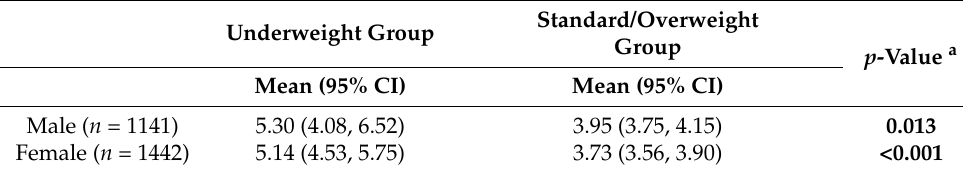
Table 3. Characteristics of body weight and GDS according to sex. Underweight